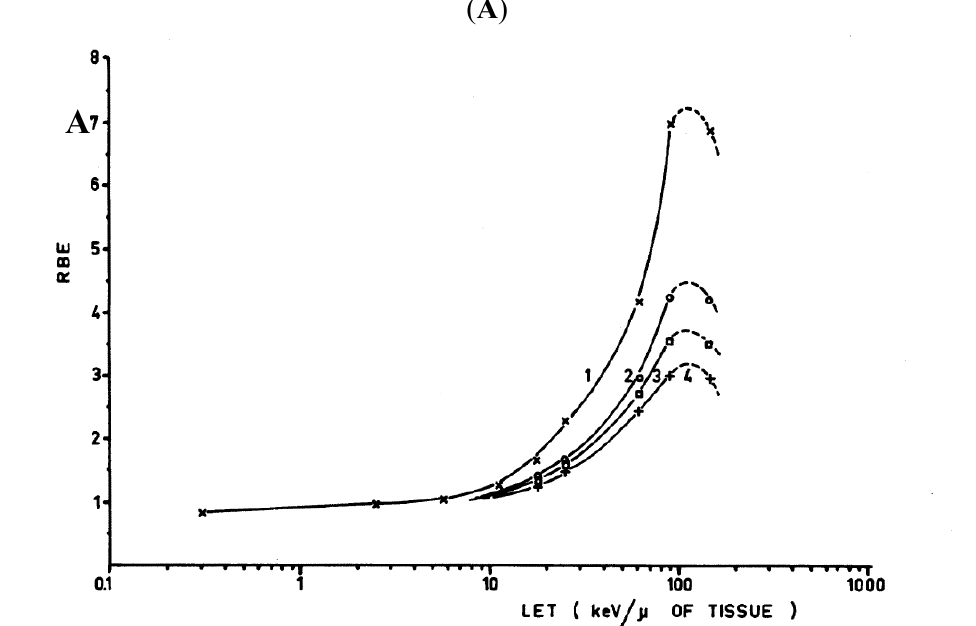
Figure 2. ( A ) Relative biological effectiveness (RBE) vs. LET for human kidney T1 cells irradiated with track segments of mono-energetic heavy charged particles. Curves 1, 2 and 3 correspond to RBE measured at survival fractions of 0.8, 0.1, 0.01. Adapted